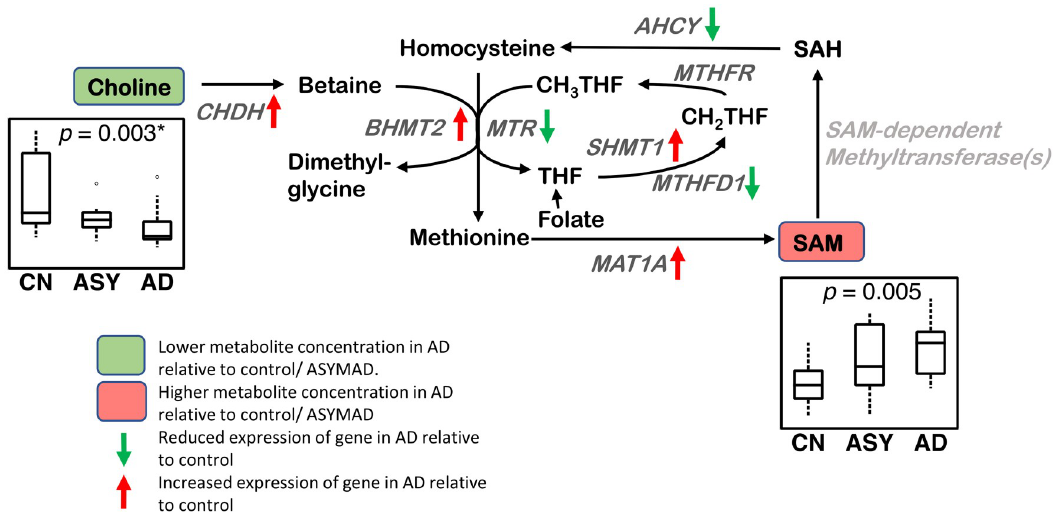
Fig 4. Methionine cycle. Differential brain concentrations of metabolites and differential gene expression of enzymatic regulators are observed in the methionine cycle in AD. Lower concentration of choline and higher concentration of SAM are observed in AD in the ITG. CHDH, BHMT2, SHMT1, and MAT1A genes have increased expression and MTR, AHCY, and MTHFD1 genes have reduced expression in the hippocampus/ERC in AD compared to CN. Sample size: AD = 17, ASY = 13, CN = 13; p -values indicate significance after FDR correction for multiple comparisons. Genes in light gray indicate expression data were not available. An asterisk ( � ) indicates metabolite was also significant after Bonferroni correction. AD, Alzheimer disease; AHCY, adenosylhomocysteinase; ASY, asymptomatic AD; BHMT2, betaine-homocysteine s-methyltransferase 2; CHDH, choline dehydrogenase; CN, Control; ERC, entorhinal cortex; FDR, false discovery rate; ITG, inferior temporal gyrus; MAT1A, methionine adenosyltransferase 1A; MTHFD1, methylenetetrahydrofolate dehydrogenase, cyclohydrolase, and formyltetrahydrofolate synthetase 1; MTHFR, methylenetetrahydrofolate reductase; MTR, 5-methyltetrahydrofolate-homocysteine methyltransferase; SAH, S-adenosyl homocysteine; SAM, S-adenosyl methionine; SHMT1, serine hydroxymethyltransferase 1.